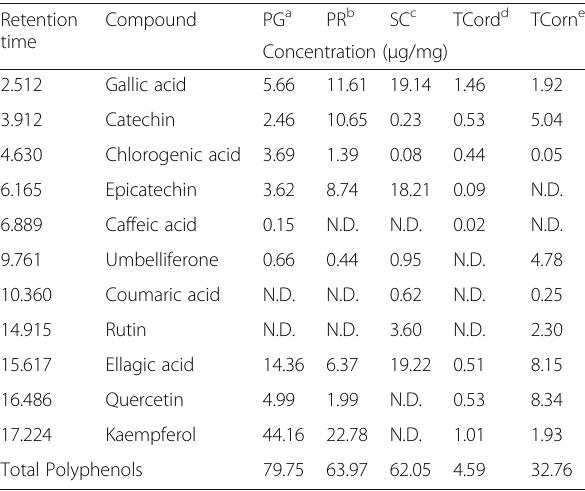
Table 6 HPLC-PDA quantification of polyphenolic compounds in plant extracts